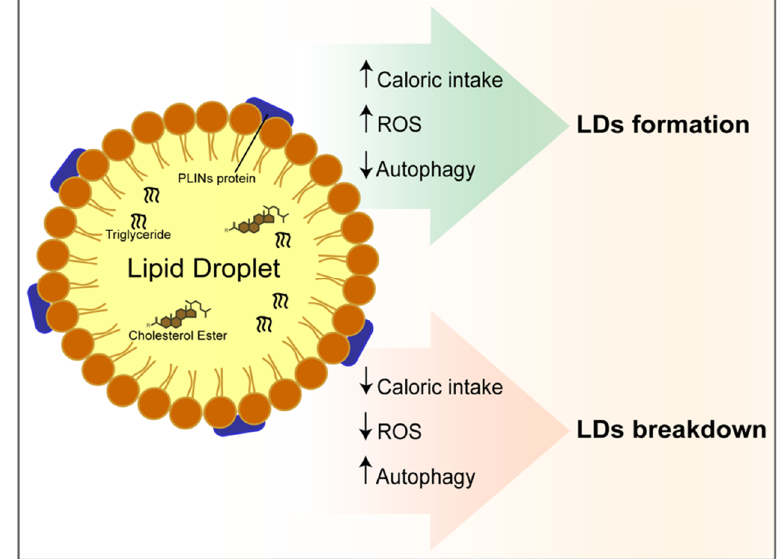
Figure 4. Autophagy at the crossroad between oxidative stress, lipids accumulation and cell death in a hypercaloric diet. Lipid droplets consist of a hydrophobic core of neutral lipids, surrounded by a phospholipid monolayer characterized by perilipins (PLINs) proteins. The core of LDs is composed of triglycerides and cholesterol esters. The figure shows the positive and negative correlation between reactive oxygen species (ROS), autophagy and diet with LDs formation or breakdown.